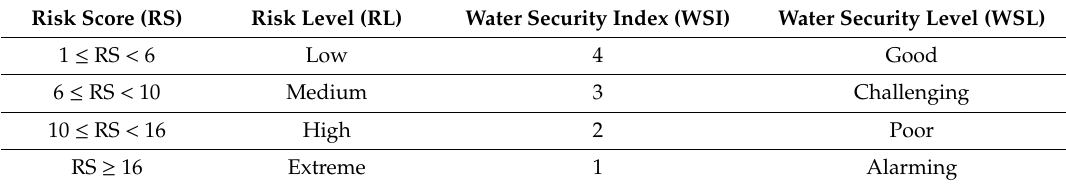
Table 4. Determination of the water security index